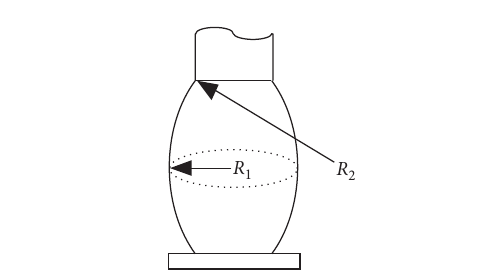
Figure 9: Molten metal